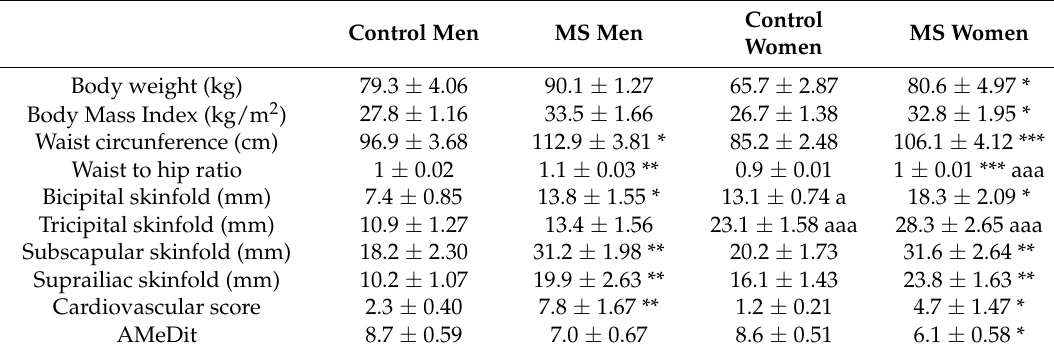
Table 1. Mean values ± standard error of body weight, Body Mass Index, anthropometrics skin folds (Bicipital, Tricipital, Subscapular and Suprailiac), waist circumference, waist-to-hip ratio, cardiovascular score, and Mediterranean diet adherence, corresponding to the four groups studied.